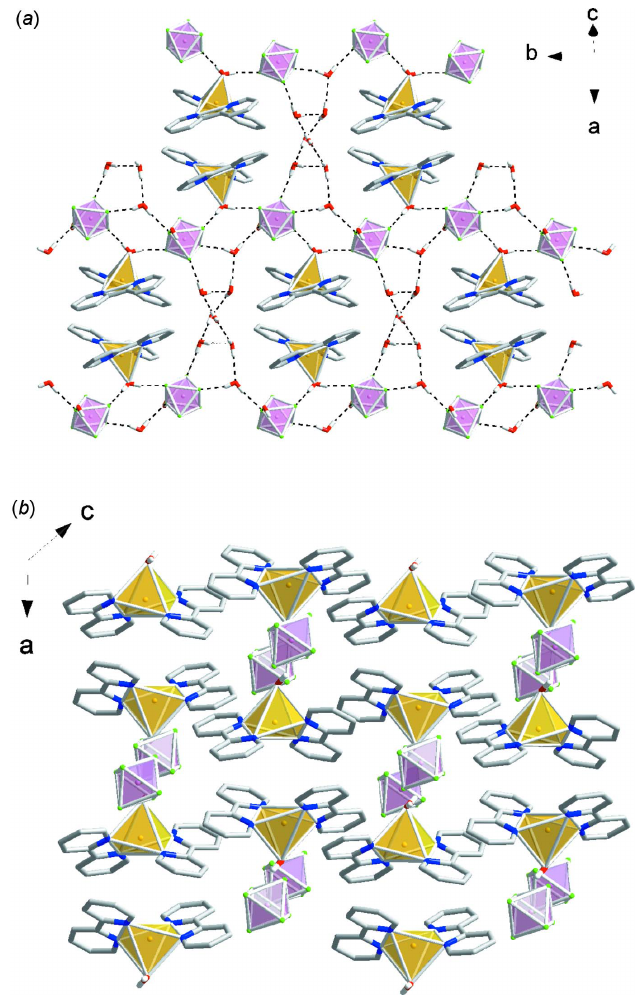
Figure 5 Packing diagram for (I): yellow polyhedra represent Cu(bpy) 2 (H 2 O) 2+ cations and pink polyhedra represent SiF 62 (cid:3) anions.